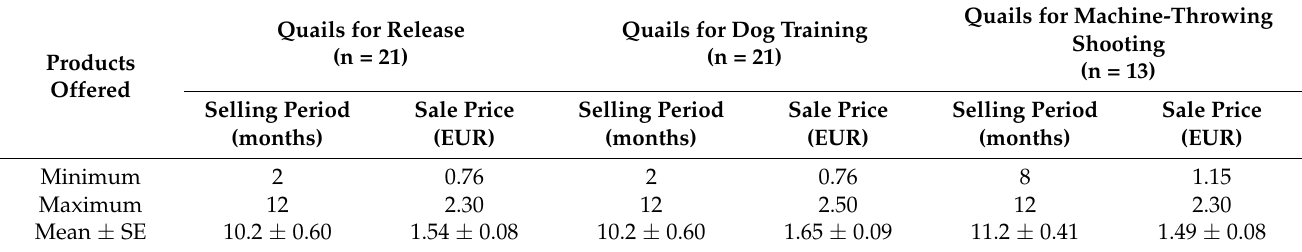
Table 6. Sale price (EUR, Euro), and the number of months per year that the birds were sold, for the different products offered by quail game farms (n =